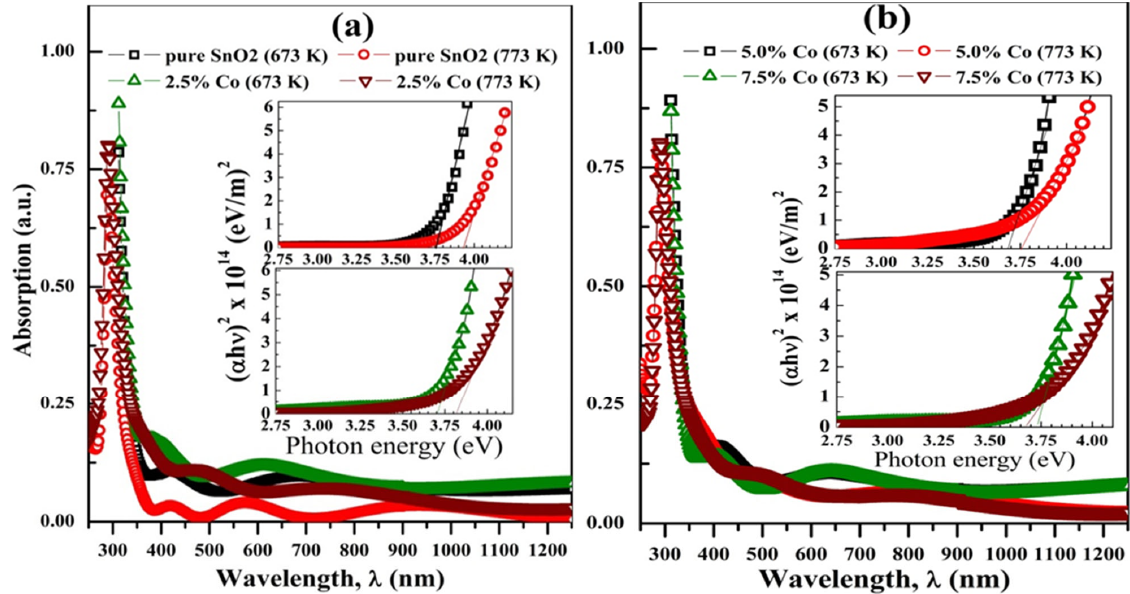
Figure 4. Optical absorption spectra of ( a ) pure and 2.5 at.%, and ( b ) 5.0 at.% and 7.5 at.% Co ‐ doped tin oxide films at 673 and 773 K. The insets are Tuac’s plots for bandgap determination. erties of SnO 2 . Yang et al. [17] reported a decrease in the E g of SnO 2 from 3.45 to 3.33 eV after